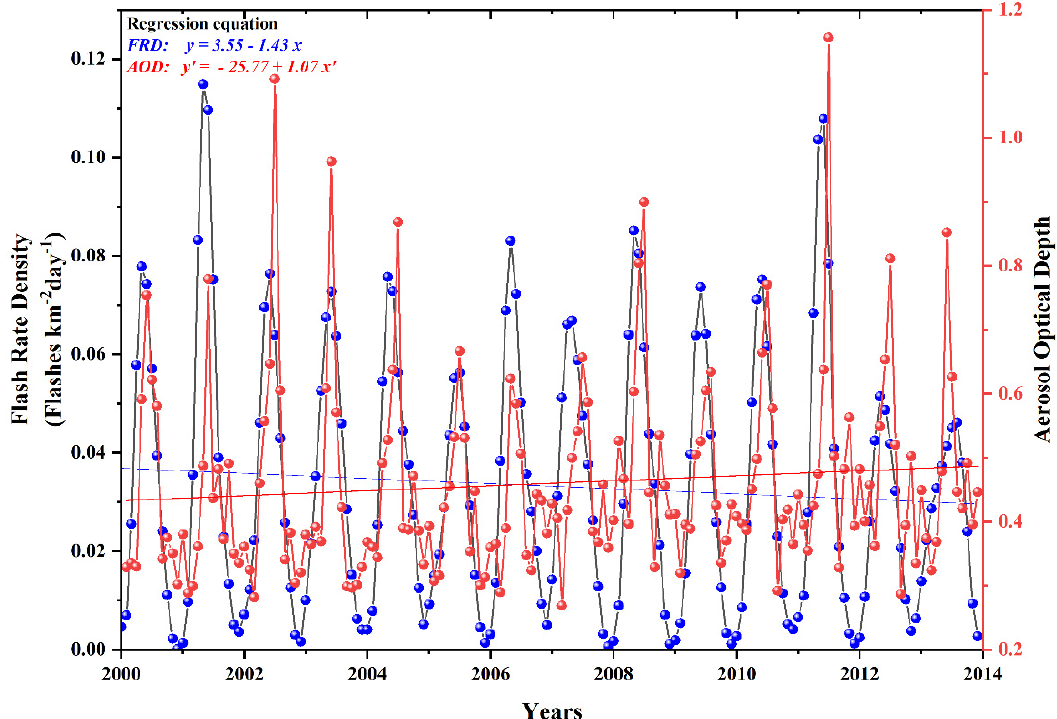
Figure 8. Monthly time series of lightning flash rate density (LFRD) and AOD from the year 2000 to 2013 over the study region.